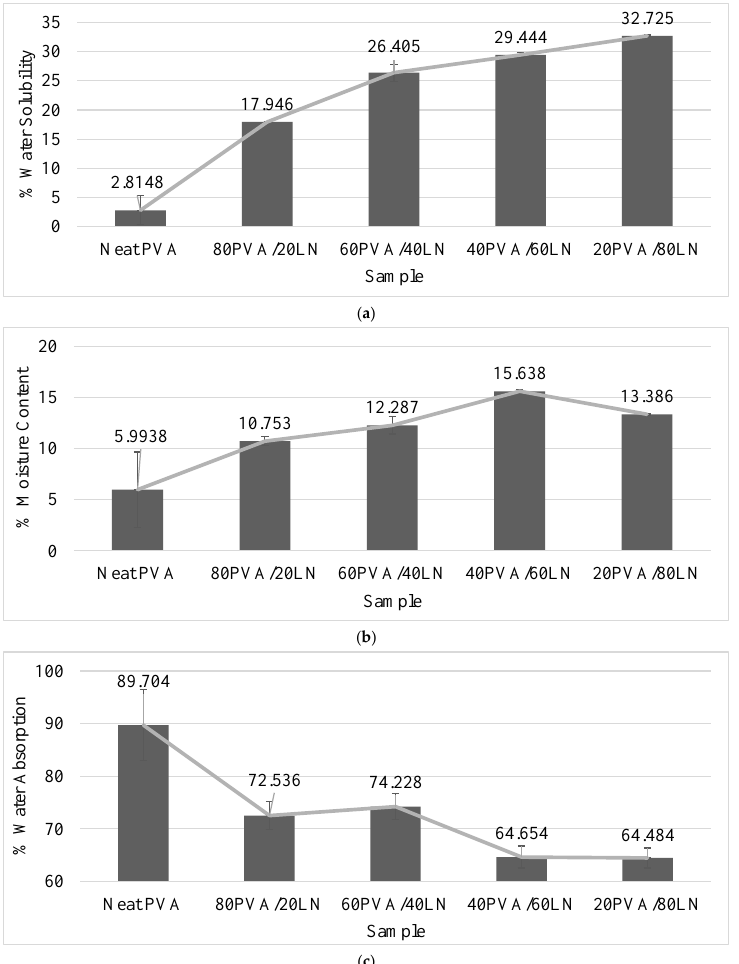
Figure 4. Results from film contact with water: ( a ) water solubility; ( b ) moisture content; ( c ) water absorption.